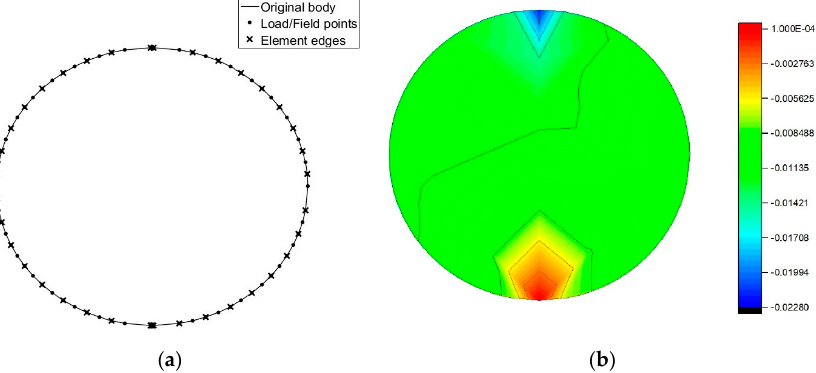
Figure 11. Cylinder under load P solve with conventional BEM. ( a ) Analysis points used as field/load points and element edges to solve the problem with BEM. ( b ) Cylinder under load; the plot colors represent the displacements in Y direction.